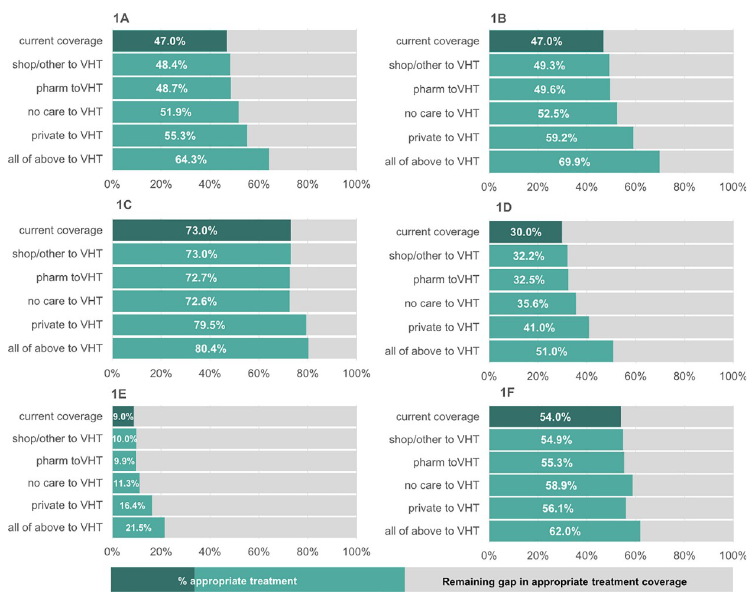
Fig 1. Predicted changes to the overall coverage of appropriate treatment for suspected/confirmed malaria, diarrhoea, and suspected pneumonia if caretakers of sick children switched from non-public sector providers or from not seeking care, to instead visiting the VHT as their first port of call for advice and/or treatment. Dark green bars show the current overall coverage rate of appropriate treatment for suspected/confirmed malaria, diarrhoea, suspected pneumonia or any episode of these. Lighter green bars show the predicted coverage rates of appropriate treatment if, all else being equal, caretakers currently using general shops, traditional healers or mobile services (OTHER), pharmacies (PHARM), private facilities or doctors (PRIVATE), not seeking care at all (NO CARE), or all those going to these providers combined (ALL OF ABOVE), switched to first using the VHT instead. 1a –all episodes of MDP; 1b –suspected malaria; 1c –confirmed malaria; 1d –diarrhoea (coverage of ORS treatment); 1e –diarrhoea (coverage of ORZ plus zinc treatment); 1f –suspected pneumonia.